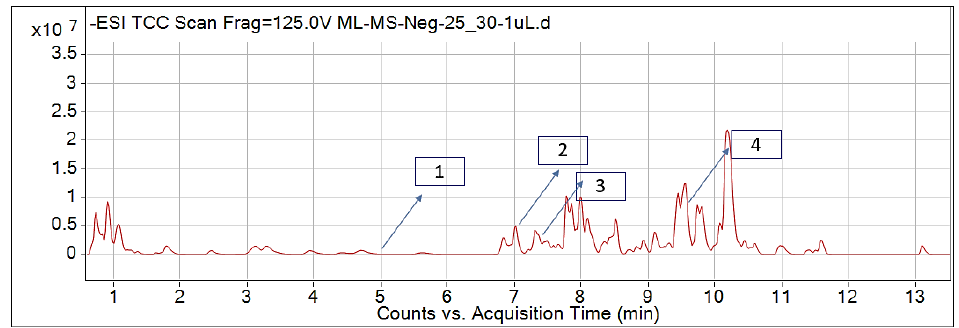
Figure 2. LC-MS chromatograms showing the phytotoxic compounds negative ion mode of P. hysterophorus leaf methanolic extract (1. P-Anisic acid, 2. Caffeic acid, 3. Vanillic acid, and 4. Ferulic acid).